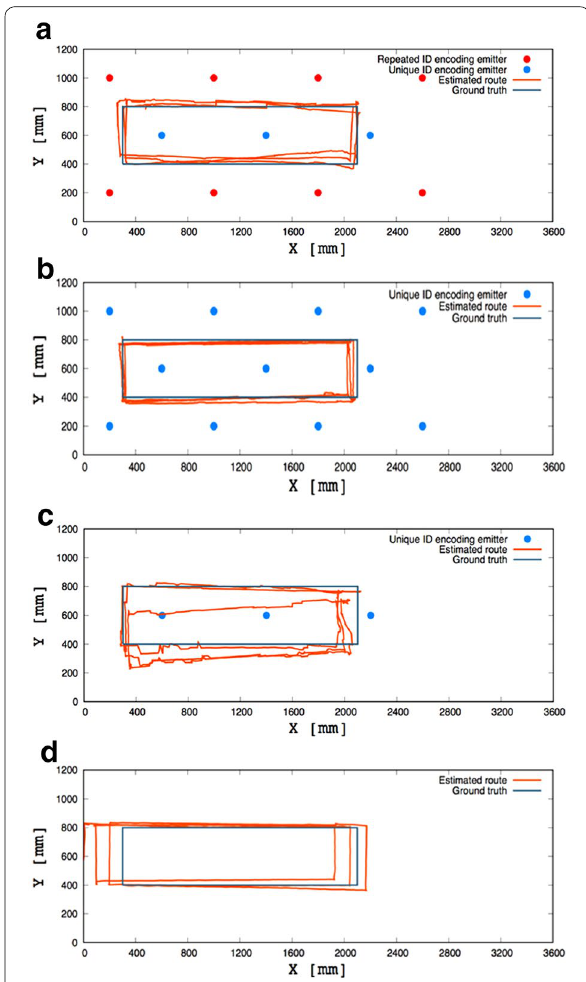
Fig. 9 Real-time self-localization with different configurations: result of real-time estimation with a a combination of unique ID and repeated ID encoding emitters; b 11 unique ID encoding emitters; c 3 unique ID encoding emitters; d only